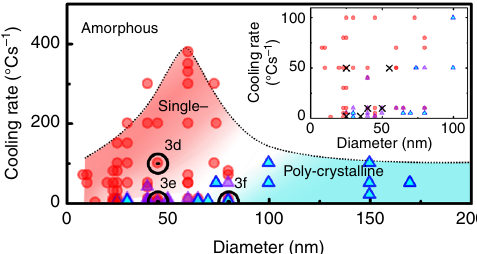
Fig. 4 Tailoring crystallization phases of nanorods with a diameter- dependent critical cooling rate. A diagram of a diameter-dependent critical cooling rate of MG nanorods to show tunable crystallization phases. Red circles, purple triangles, and blue triangles indicate an apparent single crystalline phase, a polycrystalline phase with no detectable chemical compositional difference from the glass phase, and a polycrystalline phase with different chemical compositions, respectively. The black circles indicate crystallization phases shown in Fig. 3d – f. A dotted black line is to show the critical cooling rate, fi tted by the local regression model using R software. (Inset) A magni fi ed graph of the small diameter ( < 100 nm) and low cooling rate regime ( < 100 °Cs − 1 ). Black crossed marks